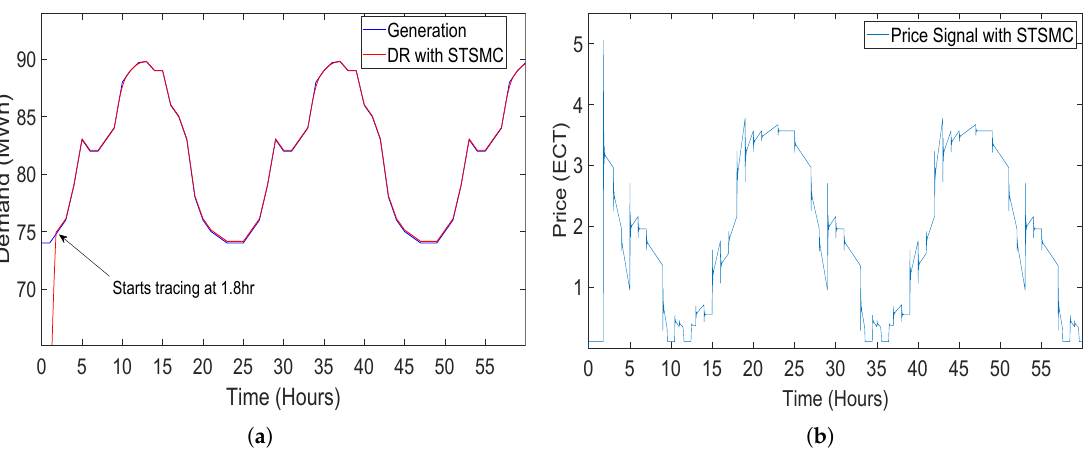
Figure 18. Closed-loop elastic demand control using super twisting sliding mode (STSMC) controller having coefficient values K 1 = − 26, K 2 = 0.0000001 and K 3 = − 30: ( a ) demand response; ( b ) price